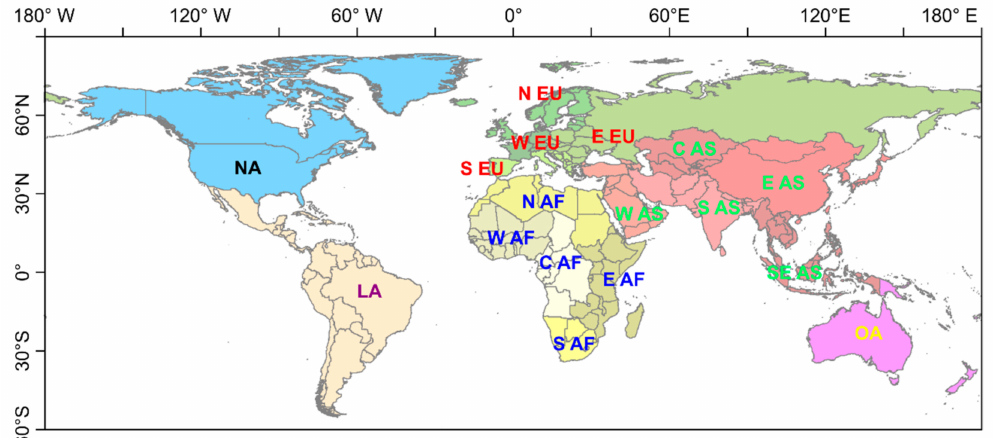
Figure A1. Administrative divisions adopted in this article: Asia is abbreviated as AS; Europe is abbreviated as EU; Oceania is abbreviated as OA; Africa is abbreviated as AF; North America is abbreviated as NA; and Latin America is abbreviated as LA. East is abbreviated as E; West is abbreviated as W; Central is abbreviated as C; North is abbreviated as N; and South is abbreviated as S. The original administrative boundaries and their spatial divisions are drawn according to GADM data (http: //